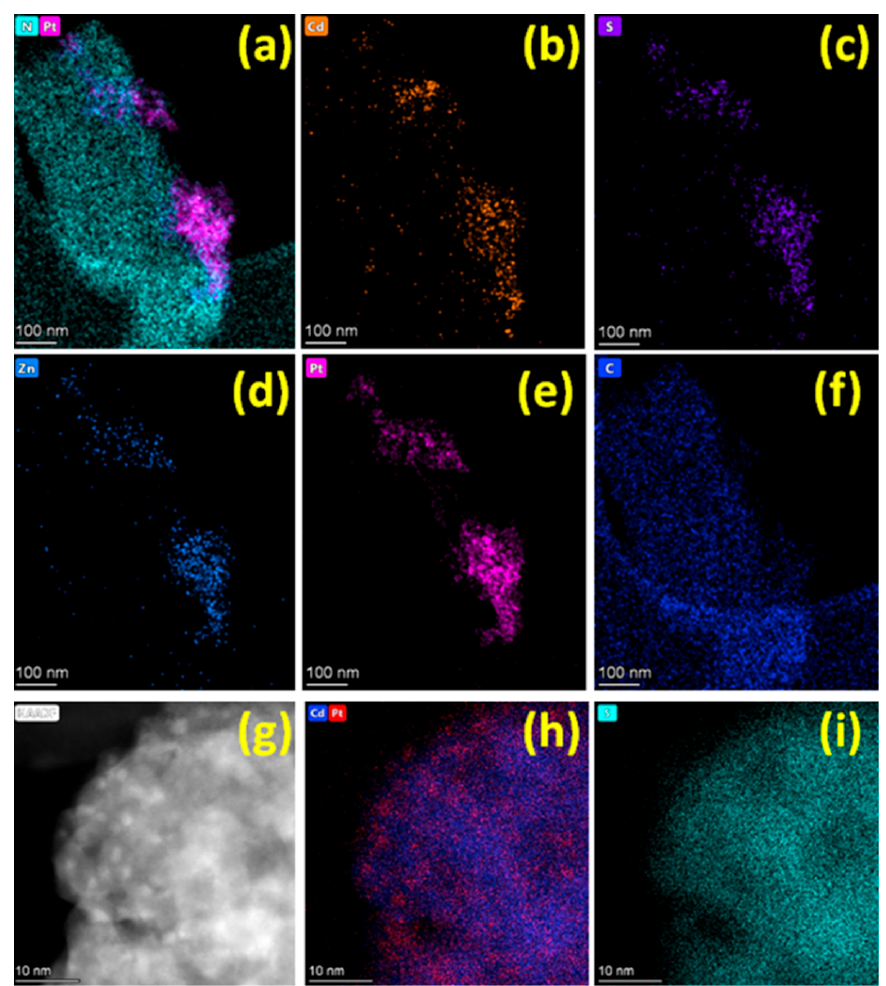
Figure 4. Elemental mapping ( a – f , h , i ) and HAADF STEM ( g ) of the photocatalyst Pt/20Cd0.8/CN. TEM analysis suggests that the Pt/20Cd0.8/CN (Scheme 1) and 20Cd0.8/Pt/CN (Scheme 2) photocatalysts had fundamentally different structures: in the first case, small platinum particles were deposited onto a surface of the solid solution of cadmium and zinc sulfides in the Cd 0.8 Zn 0.2 S/g-C 3 N 4 composite; in the latter case, enlarged platinum clusters were located on the surface of graphitic carbon nitride. A similar structure was also confirmed by XPS data, since in the second case, the surface content of platinum was much lower. In addition, according to XPS data, in the first case, platinum was present in oxidation states Pt 0 and Pt 2+ , while in the latter, it was only metallic state Pt 0